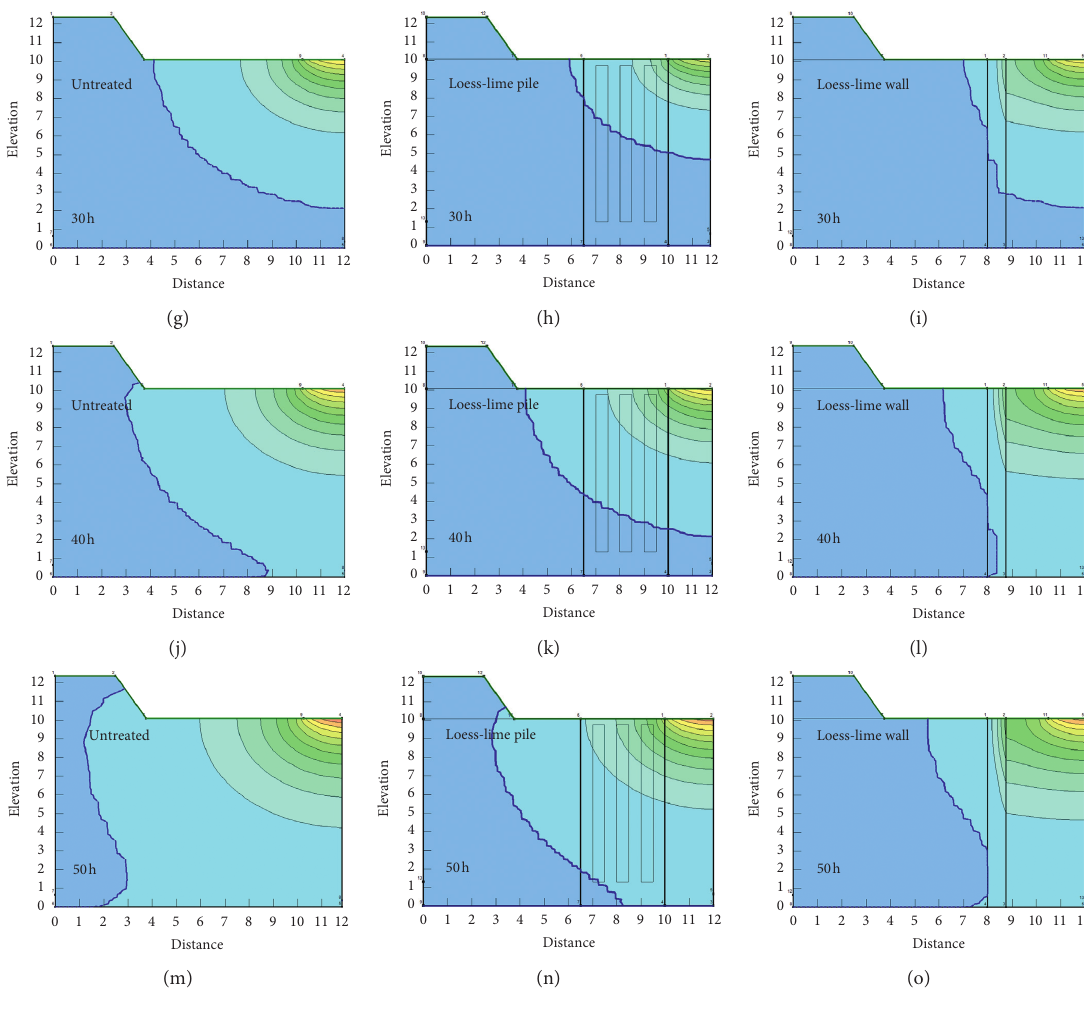
Figure 9: GeoStudio numerical analysis results. Table 7: Loess parameters used in the